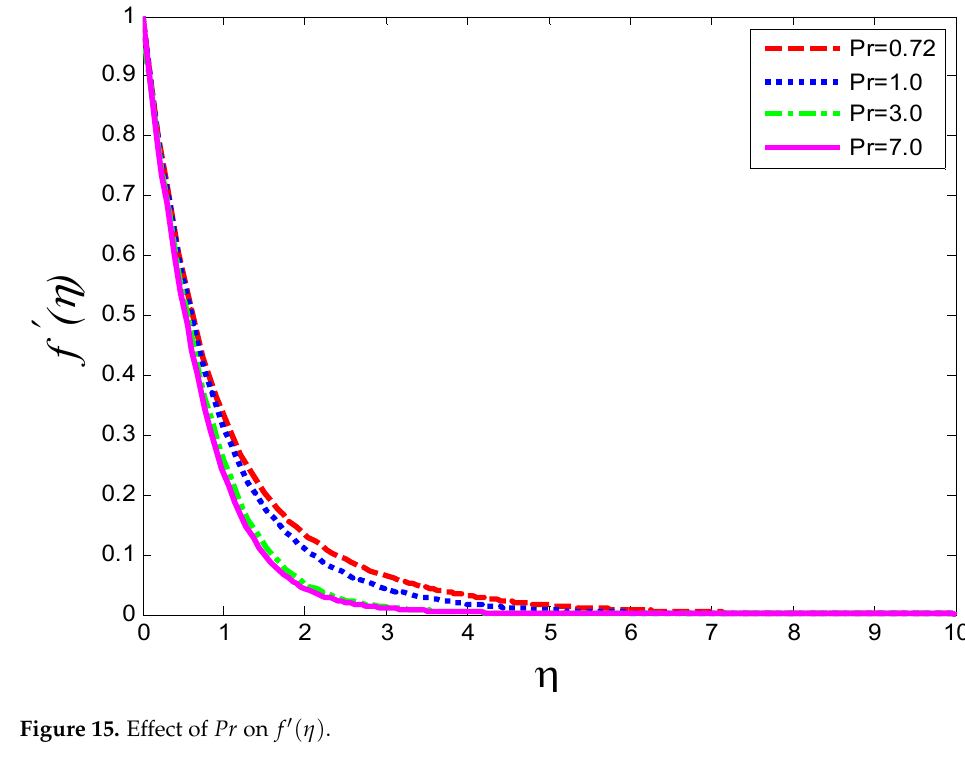
Figure 15. Effect of Pr on f (cid:48) ( η ) .